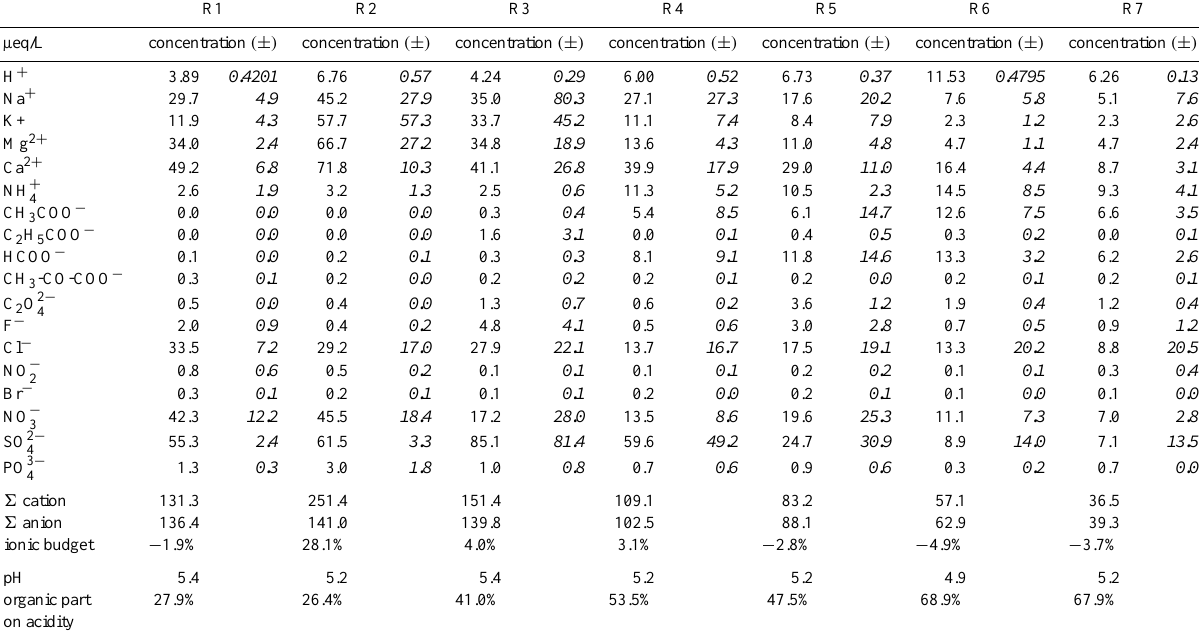
Table 3. Median chemical composition of dissolved phase of each collected rains during AMMA SOP 1 and 2. R1 R2 R3 R4 R5 R6 R7 µeq/L concentration ( ± ) concentration ( ± ) concentration ( ± ) concentration ( ± ) concentration ( ± ) concentration ( ± ) concentration ( ± ) H + 3.89